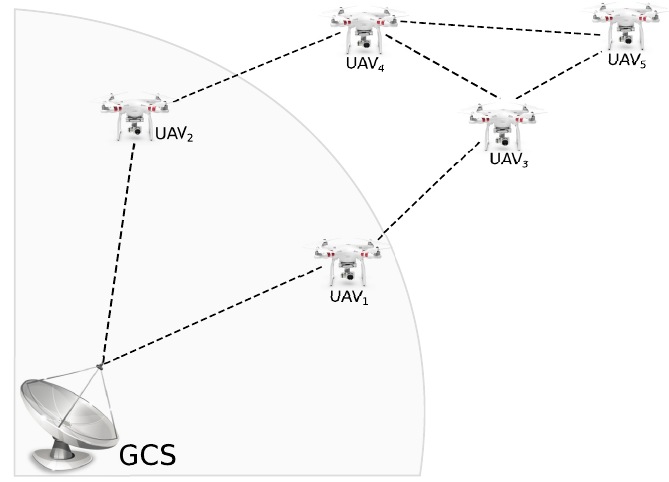
Figure 2. Simple example of a FANET (Flying ad hoc